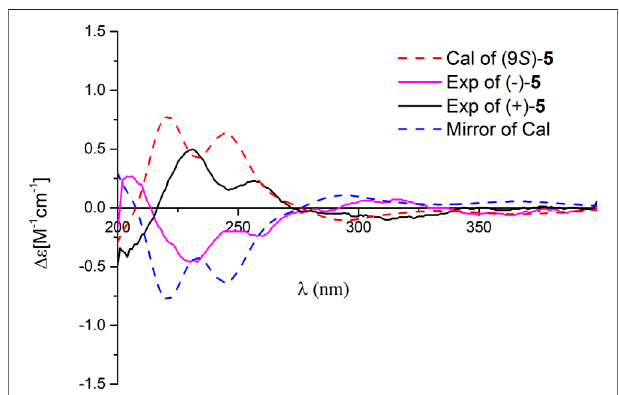
FIGURE 5 | Comparison of the calculated ECD spectrum of 5 at the PBE1PBE/def2SVP level with the experimental one in MeOH. σ (cid:1) 0.25 eV; shift (cid:1) 0